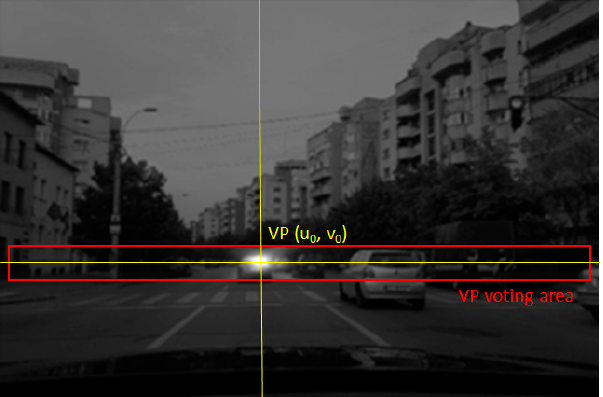
Figure 11. Finding the vanishing point (VP). The road edges will vote in the area around the already estimated horizon row, and the position with the maximum votes will be selected as the vanishing